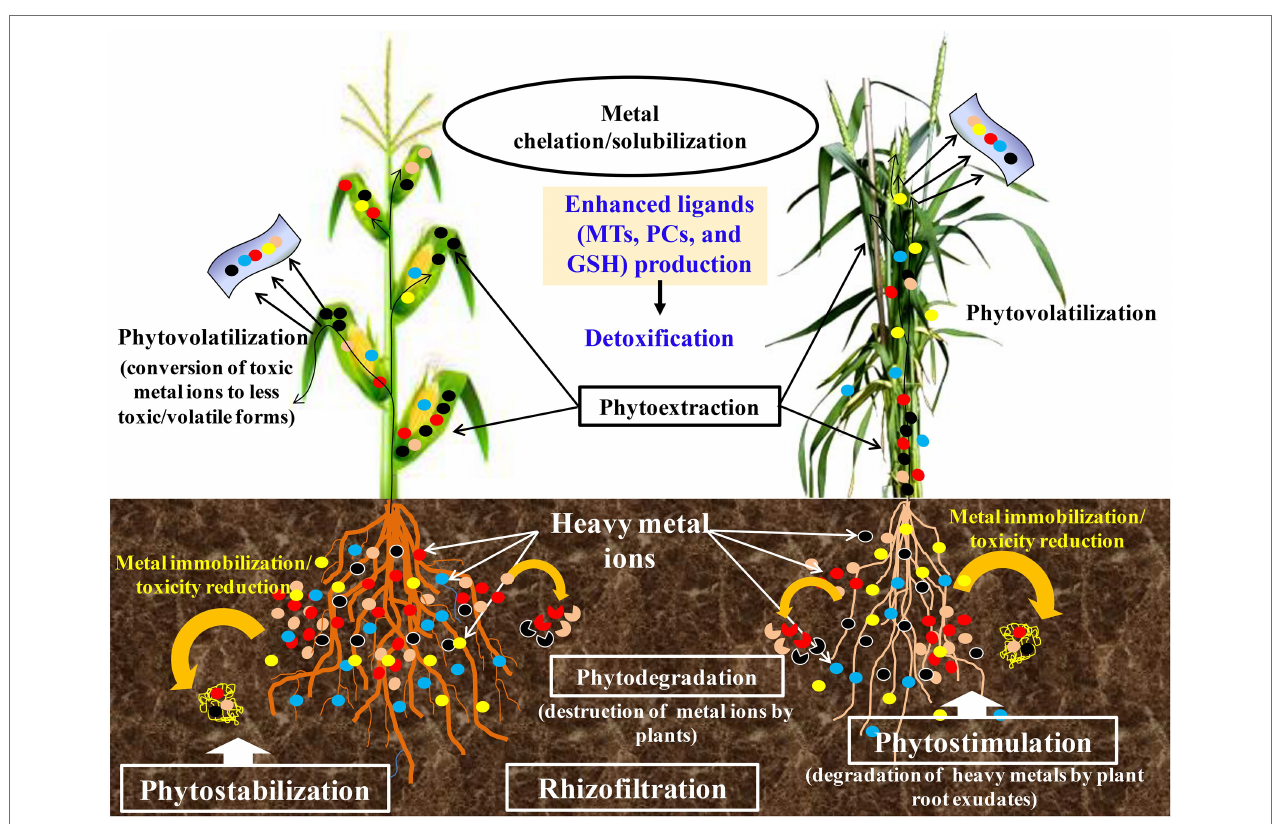
FIGURE 3 | An illustration on the phytoremediation strategies and general response of plants to potentially toxic elements stress.